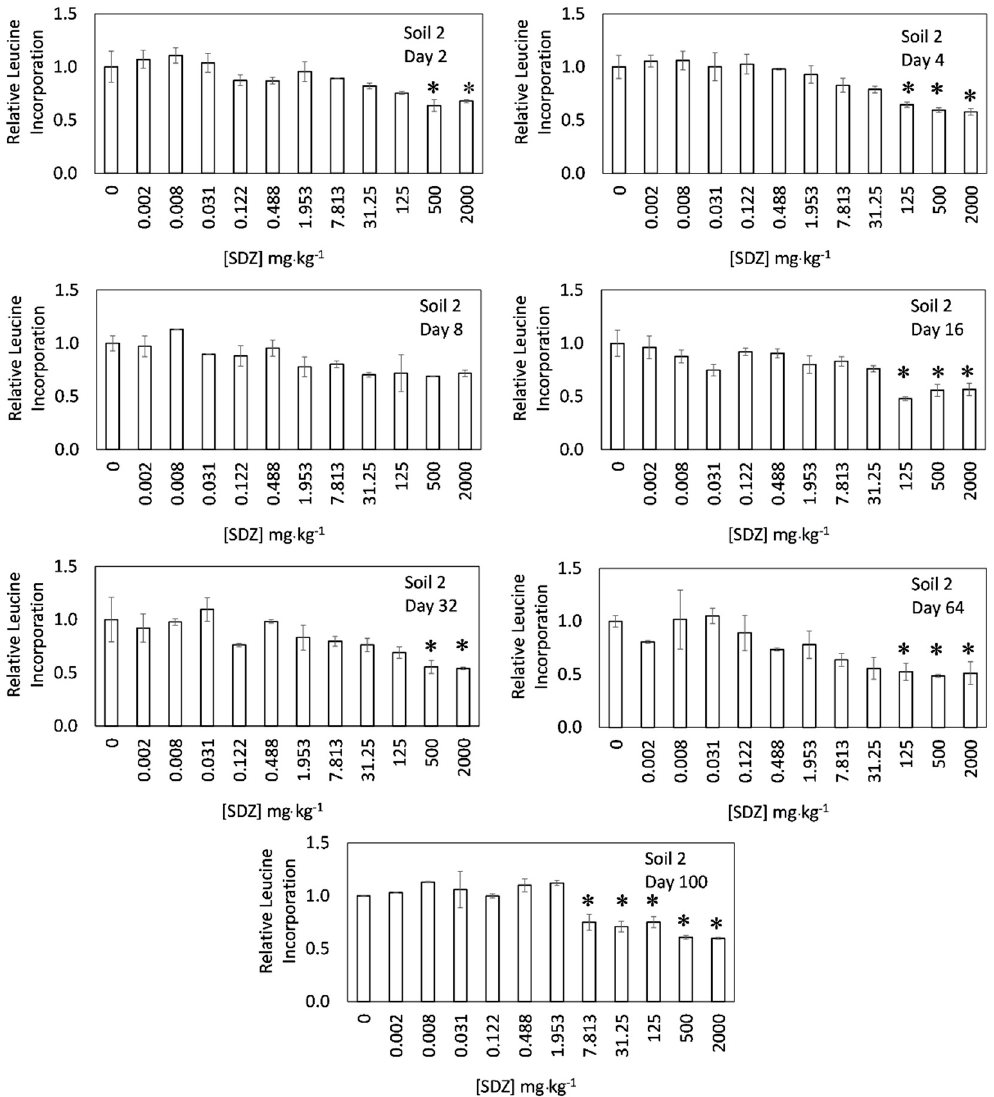
Figure 2. Relative bacterial community growth (estimated as 3 H Leucine incorporation) in soil 2 as a function of sulfadiazine concentration for different incubation times. Error bars show the standard errors from average values ( n = 3), and * indicates significant differences with respect to the control ( p < 0.05).